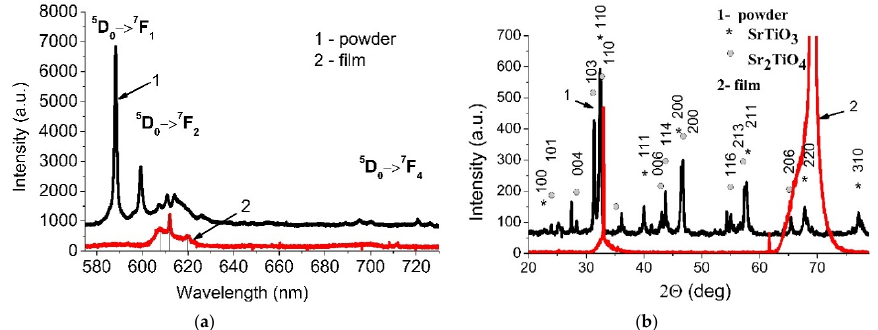
Figure 2. PL spectra of the SrTiO 3 :Eu 3+ powder and five-layer SrTiO 3 :Eu 3+ film ( a ) and diffraction patterns of the SrTiO 3 :Eu 3+ powder and the SrTiO 3 film ( b ).